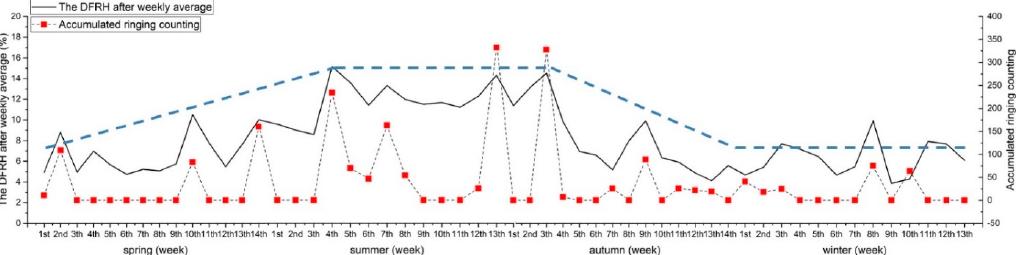
Figure 12. Relationship between DFRH after weekly average and the accumulated ringing counting throughout the year.